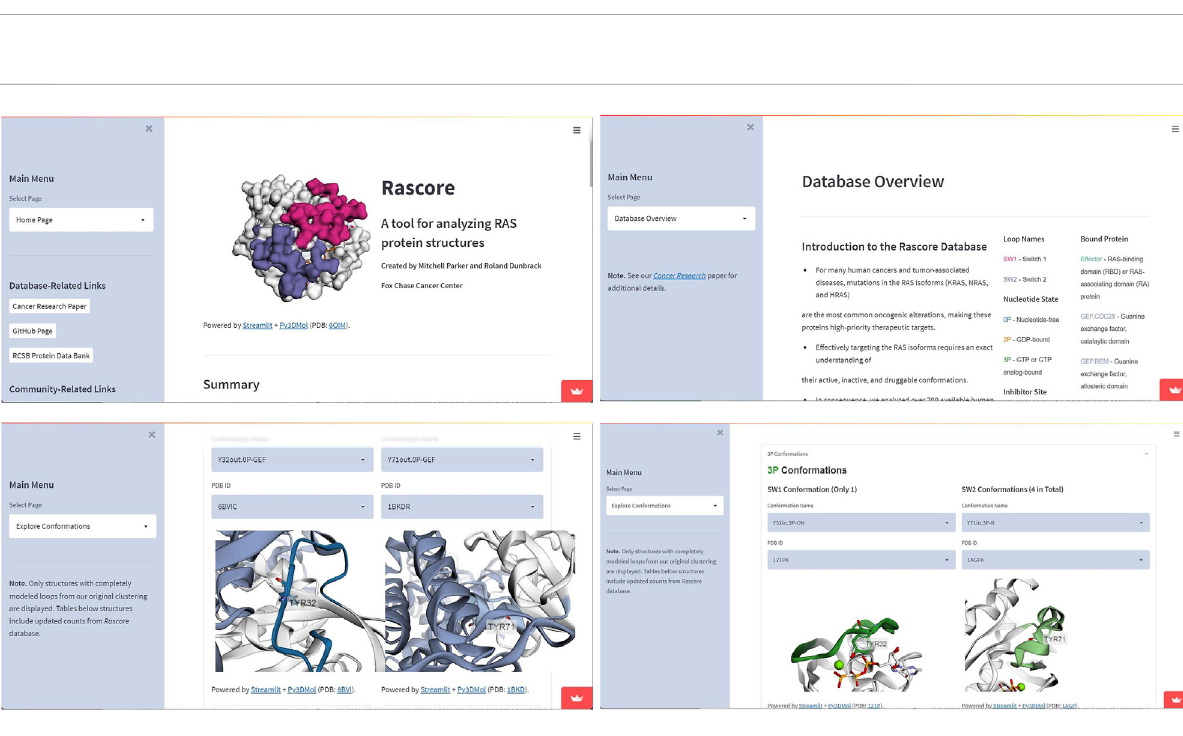
Frontiers in Molecular